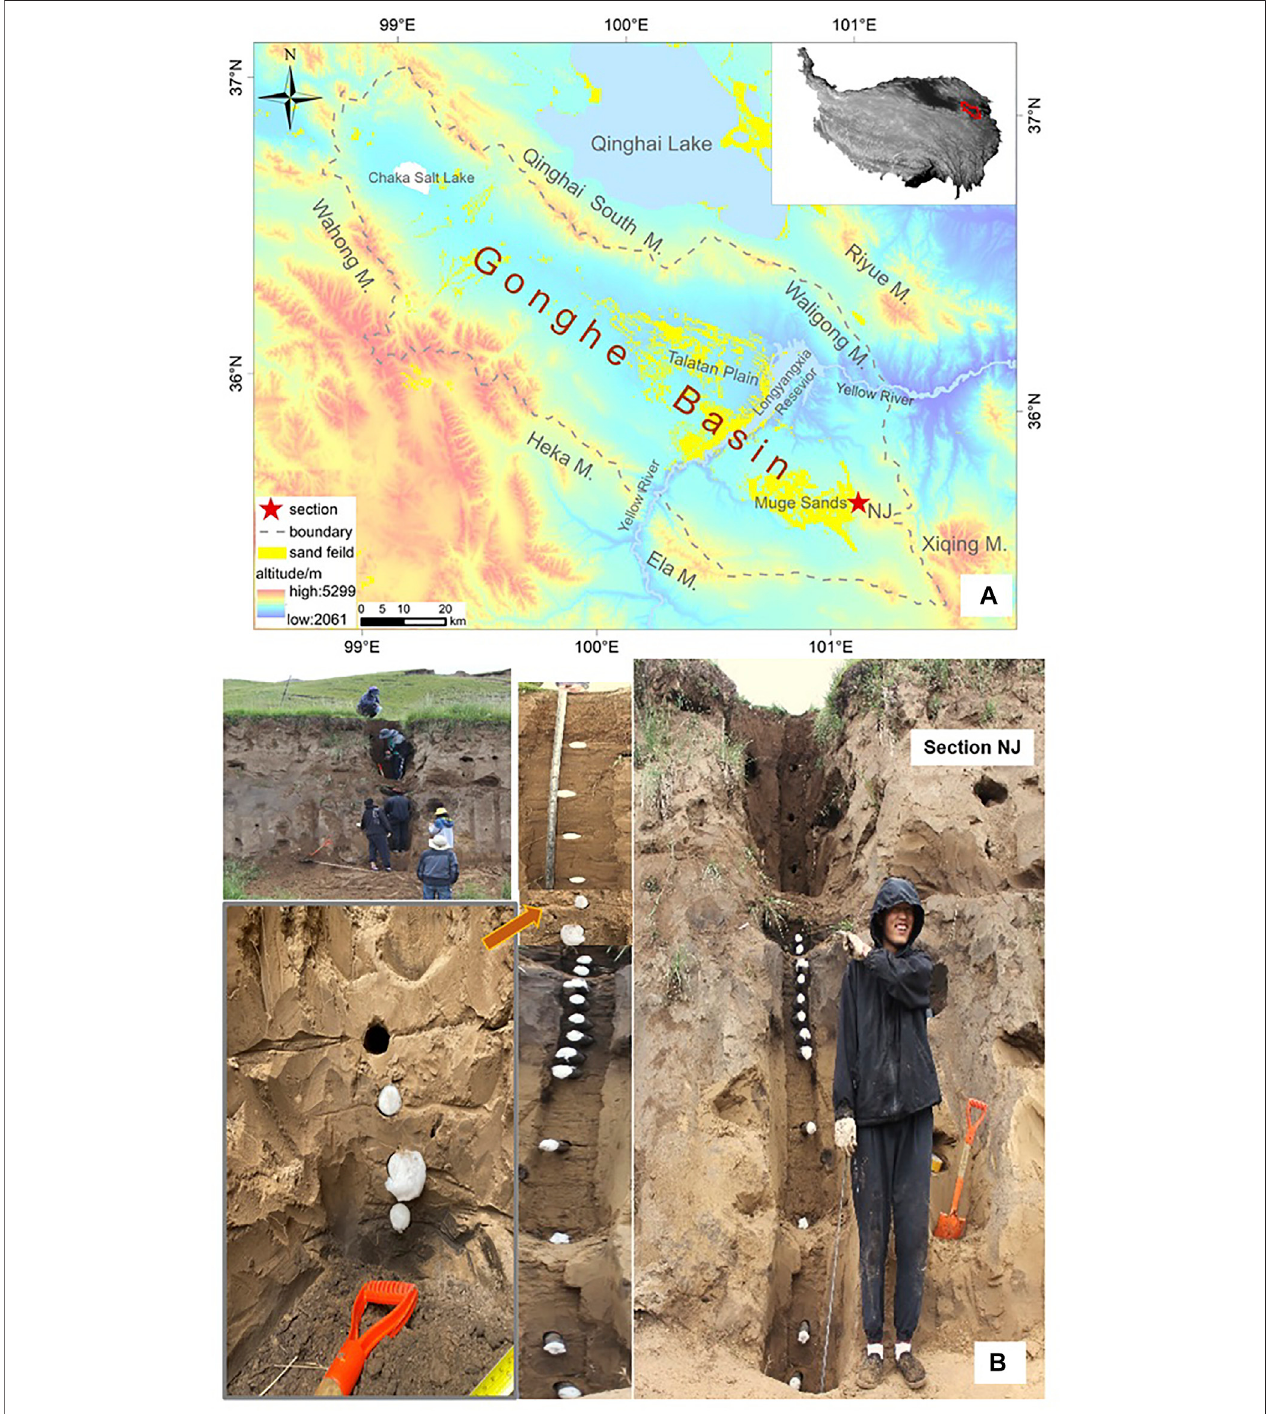
FIGURE 1 | Location maps and site details of the study area. The sand fi eld data set is provided by National Tibetan Plateau Data Center (http://data.tpdc.ac.cn). (A) Location ofGonghe Basin onthe Northeast Qinghai-Tibet Plateauand locationofthe studysection (NJ) inGonghe Basin. (B) PhotosofStratigraphies, landformsfor section